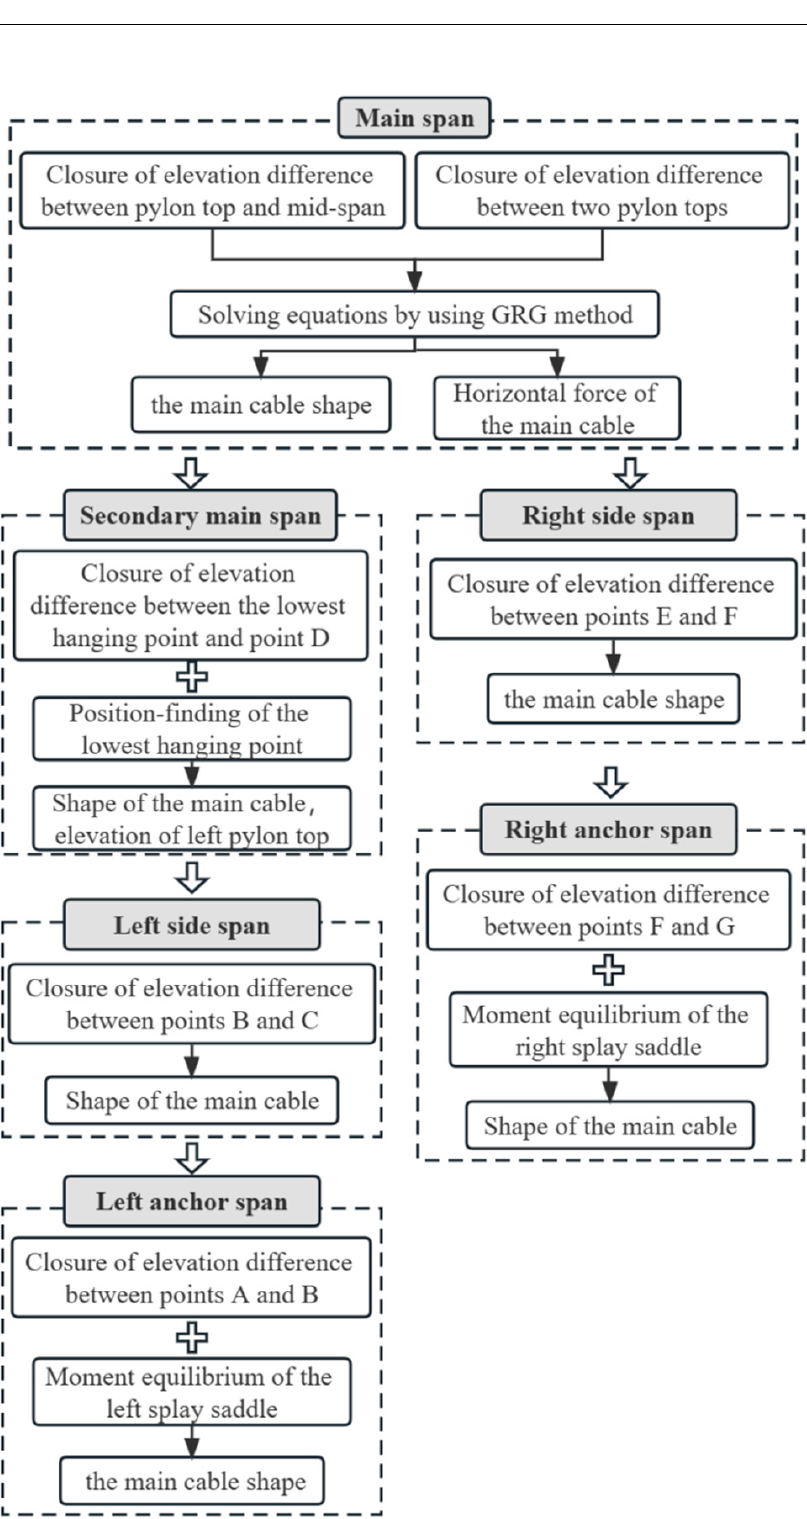
Figure 1. The main cable’s shape-finding flowchart.